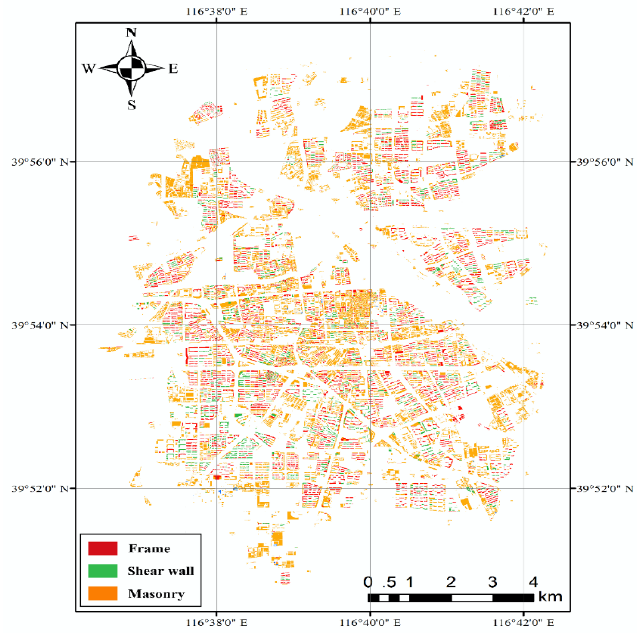
Figure 29. Distribution of structure type in Tongzhou downtown.